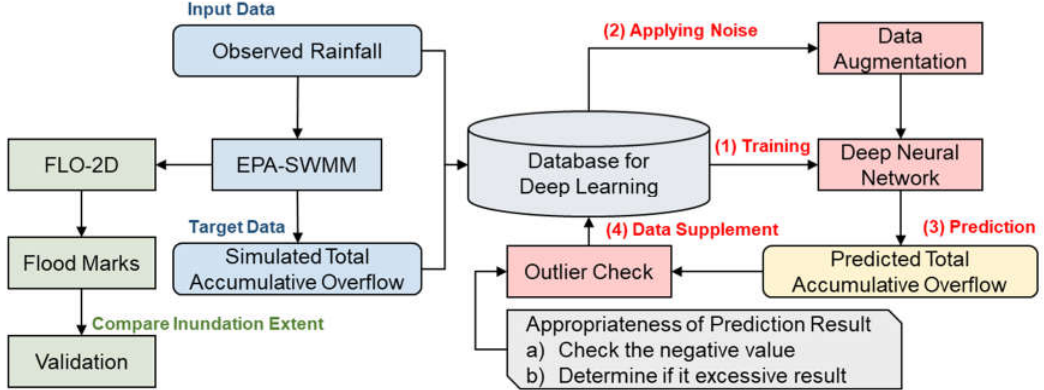
Figure 2. Flowchart for data augmentation and training the DNN.